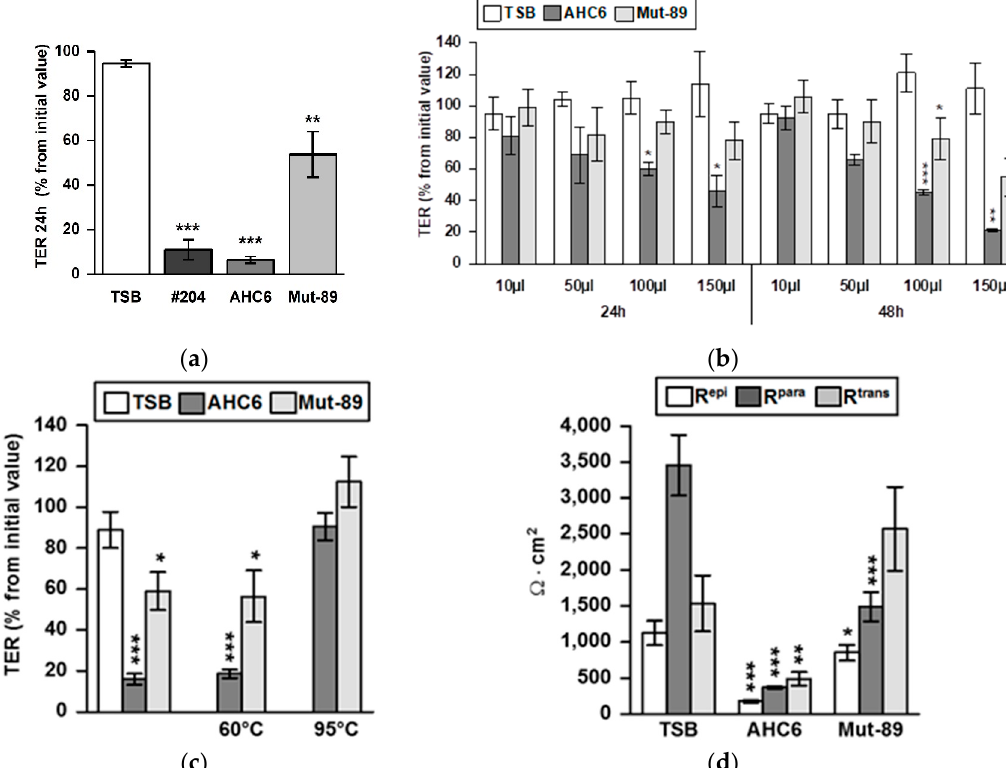
Figure 1. Tilivalline/tilimycin-dependent and -independent effects on transepithelial resistance. ( a ) T84 monolayers were infected with vital tilivalline/tilimycin-producing K. oxytoca strains #204 and AHC6 or the AHC6 isogenic mutant strain Mut-89. TER (transepithelial resistance) levels were measured at 24 h after infection and were compared with initial values (set 100%) and untreated controls ( n = 5–7; ** p > 0.01; *** p < 0.001 versus control). ( b ) Dose- and time-dependent TER effects of preparations of bacterial culture supernatants from K. oxytoca strains AHC6 and from tilivalline/tilimycin knock-out Mut-89 were assessed on T84 monolayers. Controls were treated with equal amounts of TSB culture medium ( n = 4–5; * p < 0.5; ** p < 0.01; *** p < 0.001 versus TSB). ( c ) Supernatants of ACH6 or Mut-89 were heated to 95 or 60 °C prior to T84 challenge and TER measurements ( n = 5–10; p < 0.05, p < 0.001 versus TSB). ( d ) Discrimination of paracellular (R para ) and transcellular resistance (R trans ) by two-path impedance spectroscopy was performed 48 h after challenging cellular monolayers with supernatant of AHC6 or Mut-89 ( n = 4–13; ** p < 0.01; *** p < 0.001 versus TSB control).